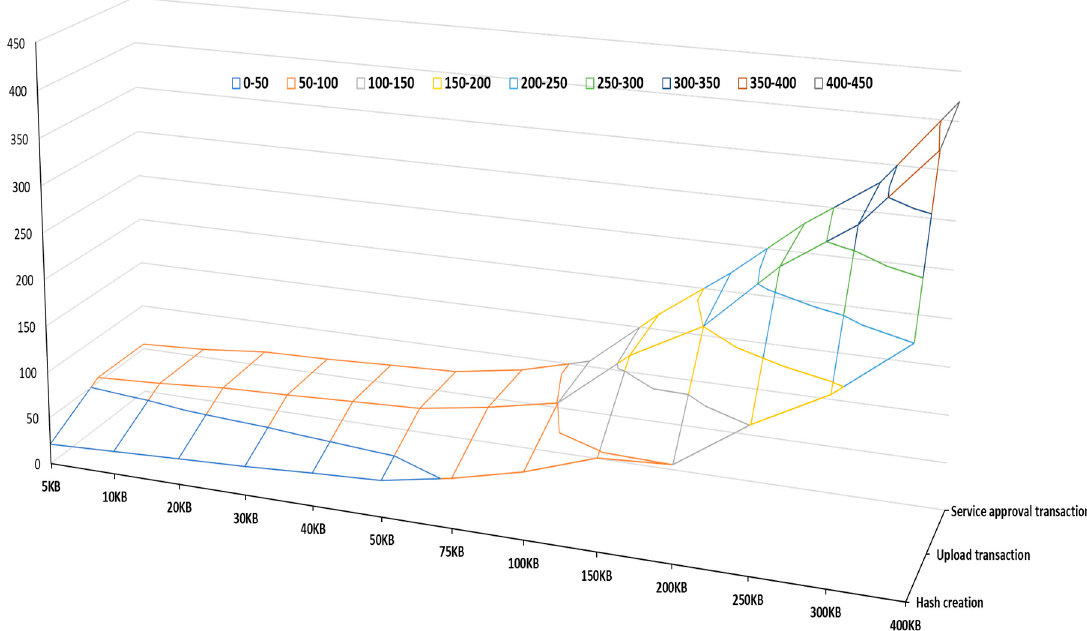
Figure 10. Surface chart of the latency of various transaction sizes: 9 different ranges. There are three key points in this chart.